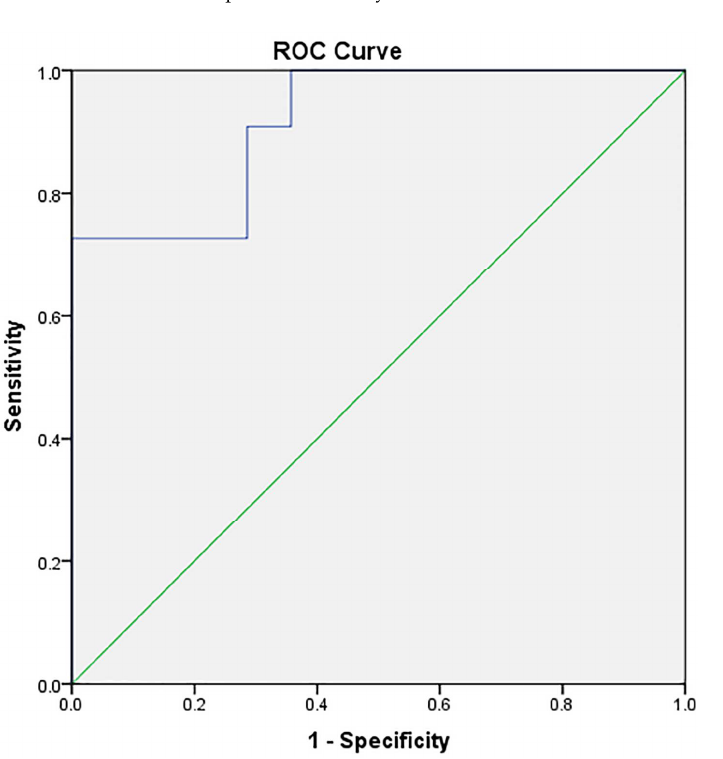
Figure 2. AUC for Model 1 using 3 parameters (preoperatively estimated pancreatic remnant volume, the main pancreatic duct diameter and the values of the unenhanced pancreatic density).